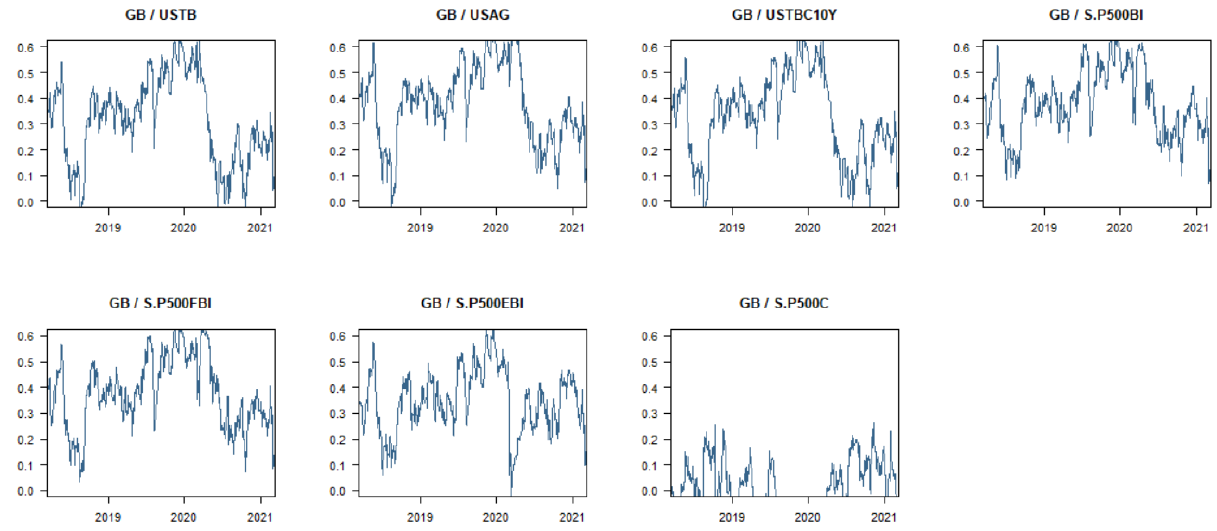
Figure 13. Dynamic Conditional Correlations.